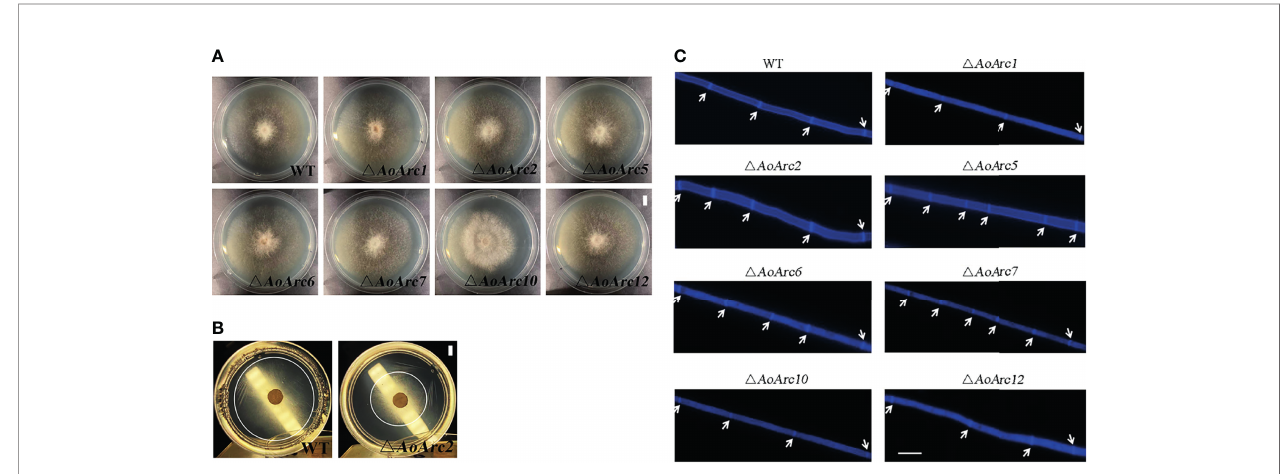
FIGURE 3 | Comparison of hyphae growth and hyphae cell length between WT and AoArc mutants. (A) Comparison of mycelial growth between wild-type (WT) and AoArc mutants; fungal strains were cultured on PDA at 28°C for 7 days (bar = 1 cm). (B) Comparison of mycelial growth between WT and D AoArc2 mutant; fungal strains were cultured on WA at 28°C for 7 days. WA is a nutrient-poor medium with weak hyphae growth. The white circle is used to indicate the size of the colony (bar = 1 cm). (C) Comparison of hyphal septum between WT and mutants. The white arrow indicates the septum (bar = 20 m